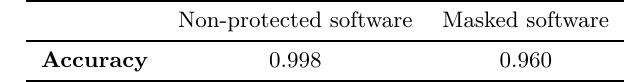
Table 7: Accuracy of the NN side-channel distinguisher in [UXT + 22] Non-protected software Masked software Accuracy 0 . 998 0 . 960